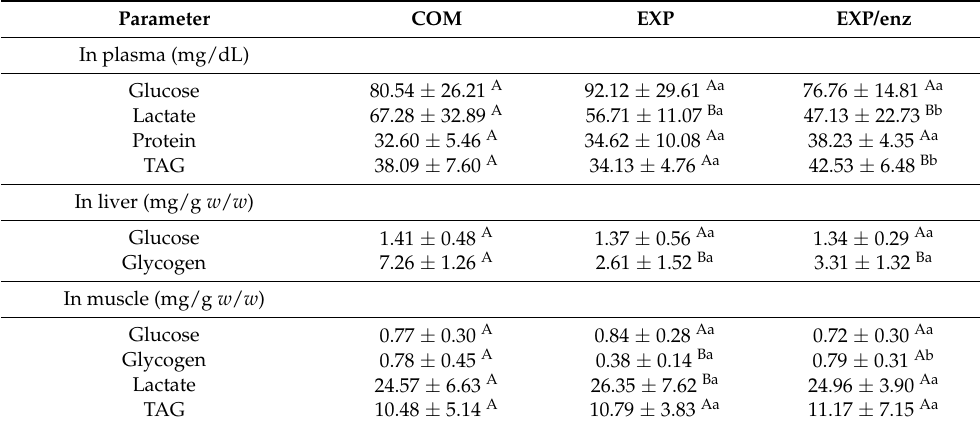
Table 4. Metabolites measured in plasma and tissues of fish fed on the different experimental